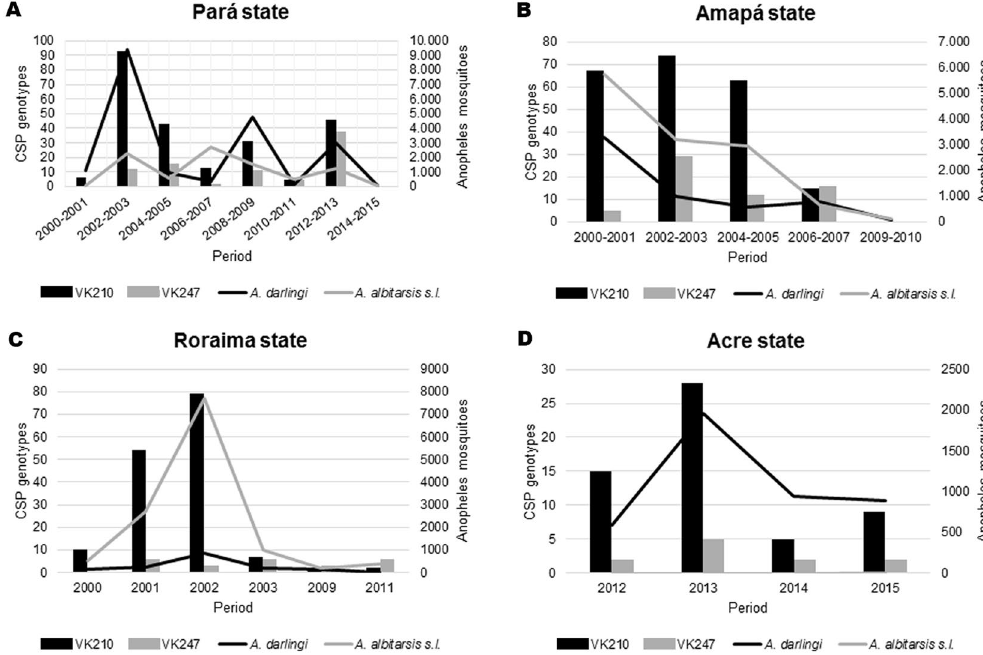
Figure 1. Frequency of P. vivax CSP genotypes and abundance of Anopheles darlingi and A. albitarsis s.l. in ( A ) Pará, ( B ) Amapá, ( C ) Roraima and ( D ) Acre states, 2000 to